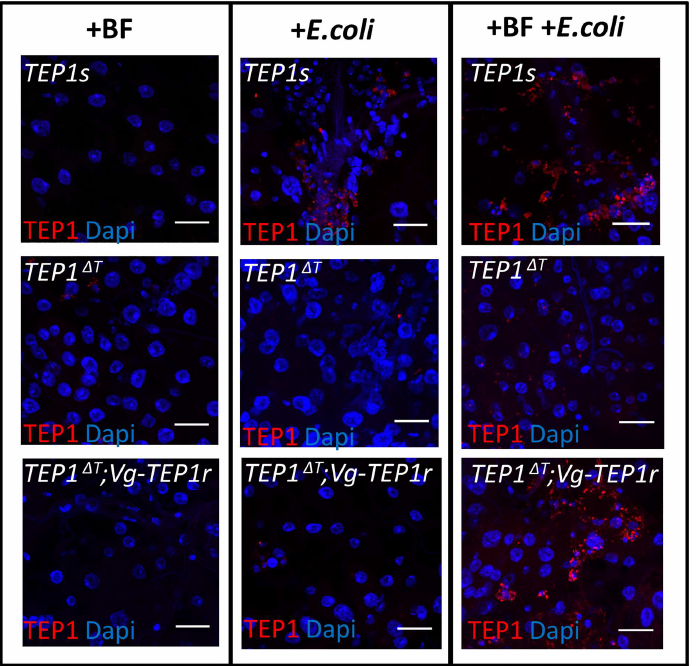
Fig 6. Fat body expressedtransgenic TEP1 enters hemocytes. TEP1 antibody staining (red) of dissected mosquitocarcasses after injectionof heat killed E . coli .Nuclei are stained with Dapi (blue). Shownare wild type ( TEP1s ), TEP1s mutant ( TEP1 Δ T ) and mutants complemented with transgenic TEP1r under control of the Vg promoter( TEP1 Δ T ;Vg-TEP1r ). Compared are bloodfed non injected (+BF), non blood fed injected(+ E . coli ) and blood fed, E . coli injectedmosquitoes(+BF+ E . coli ). scale bar = 20 μ